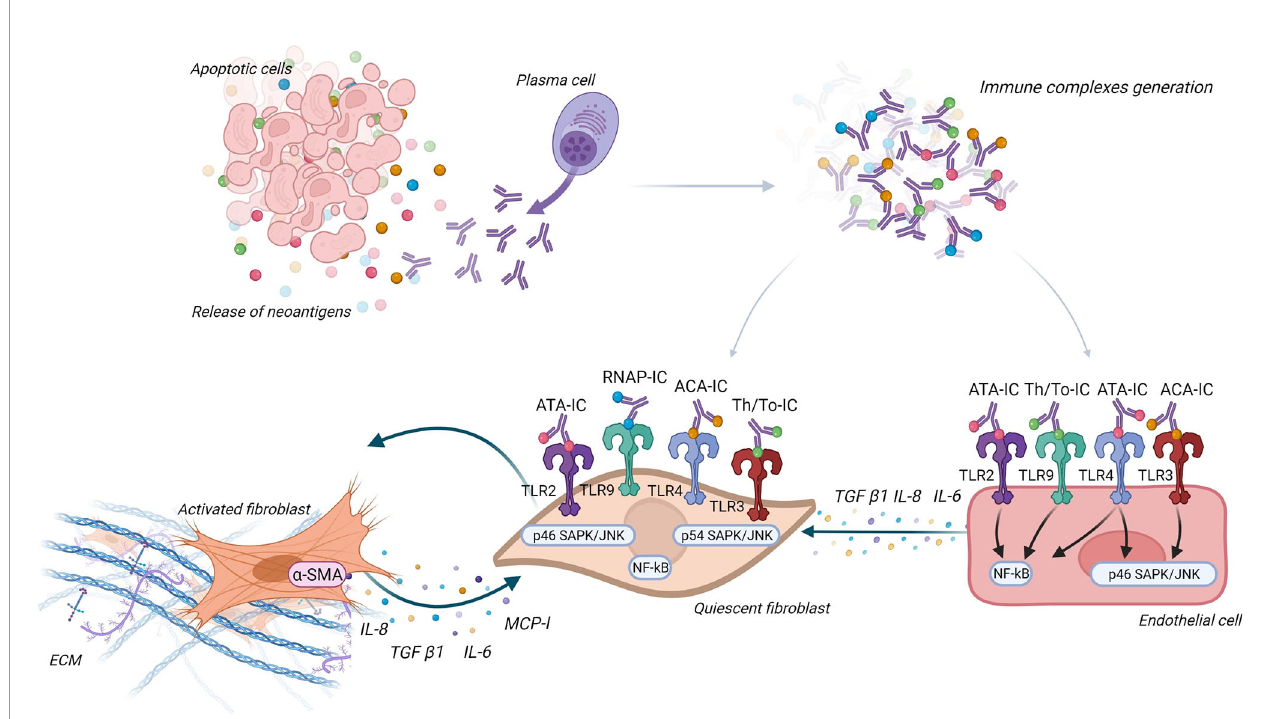
FIGURE 4 | Immune complexes theory. Antinuclear antibodies (ANA) interact with their neoantigens released by apoptotic blebs and form immune complexes (IC). These IC interact with different Toll-like receptors (TLR) according to ANA subtypes, both on fi broblast (FB) and endothelial cells. FB are then activated into myo fi broblasts and secrete extracellular matrix and proin fl ammatory and pro fi brotic cytokines. Endothelial cells engage pathways according to ANA subtype (like NF- k B and SAPK/JNK) and secrete cytokines that activate